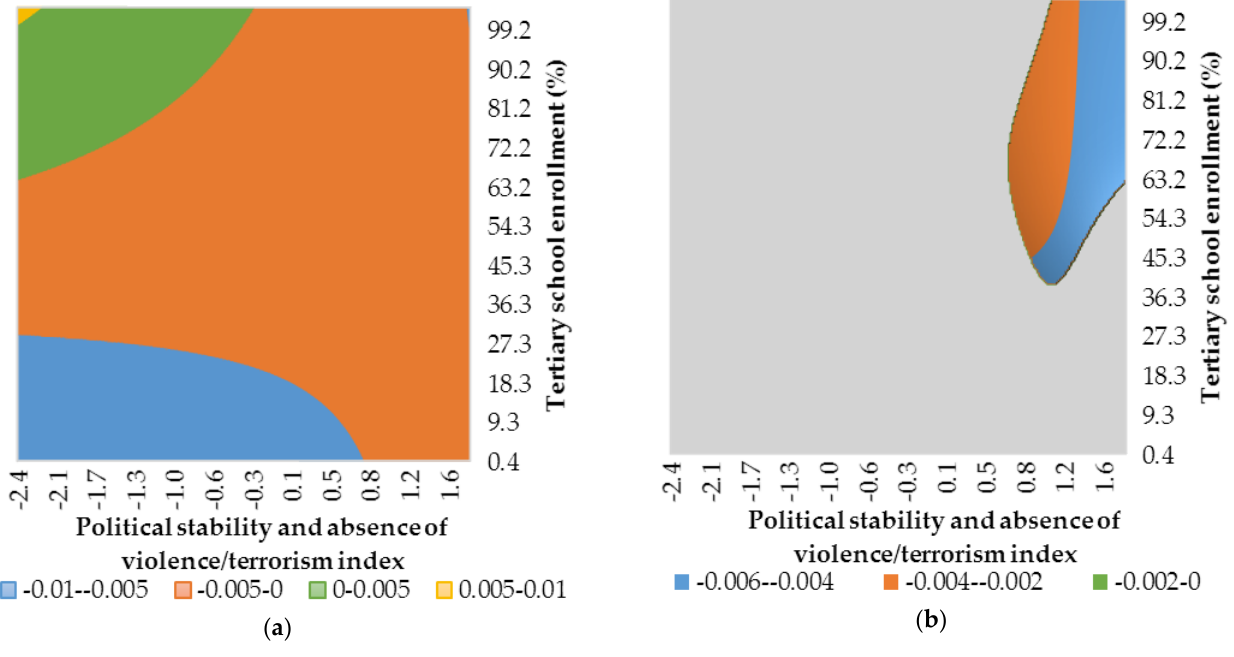
Figure A9. Conditional effect of financialisation on growth based on Est. 9 in Table A2. ( a ) Estimated conditional slope coefficient over the whole range of observed values for institutional quality and development level. ( b ) Estimated statistically significant conditional slope coefficient. Gray represents a combination of institutional quality and development level for which effect of financialisation on growth is statistically insignificant. Source: authors’ contributions.